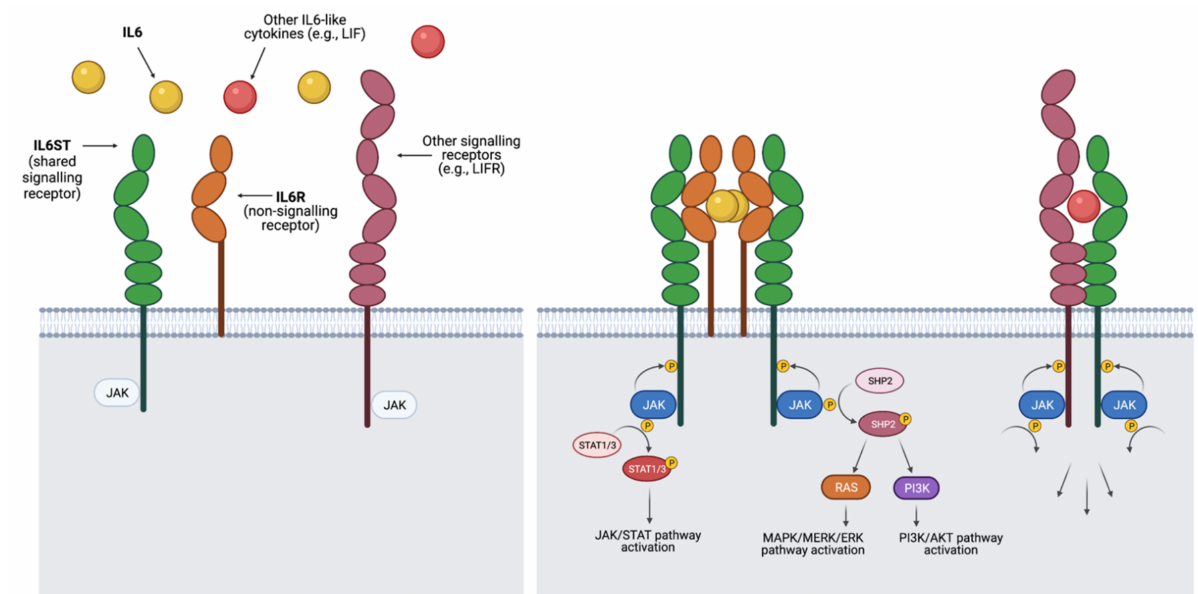
Figure 1. Summary of signalling by cytokines in the IL6-like family. Cytokines bind membrane-bound receptors with similar modular structures to form signalling complexes including 2 signalling receptors, of which at least 1 is always the shared signal transductor IL6ST. Dimerisation of these receptors leads to the activation of tyrosine kinases bound to their cytoplasmic sections, which in turn trigger a signalling cascade that can activate 3 pathways with known roles in breast cancer: JAK/STAT, MAPK/MERK/ERK and PI3K/AKT. Signalling complexes are different for each cytokine in the family. For example, IL6 is recruited by the non-signalling (lacking cytoplasmic domains) receptor IL6 receptor α (IL6R), leading to the formation of a hexameric signalling complex including an IL6ST homodimer. Other cytokines in the family form complexes comprising heterodimers (with IL6ST and a different signalling receptor) with or without the need of a non-signalling receptor, depending on the cytokine. Members of the IL6-like family can exert specific functions due to variations in ligand and receptor concentrations and in the activity of modulating signals across different cell and tissue